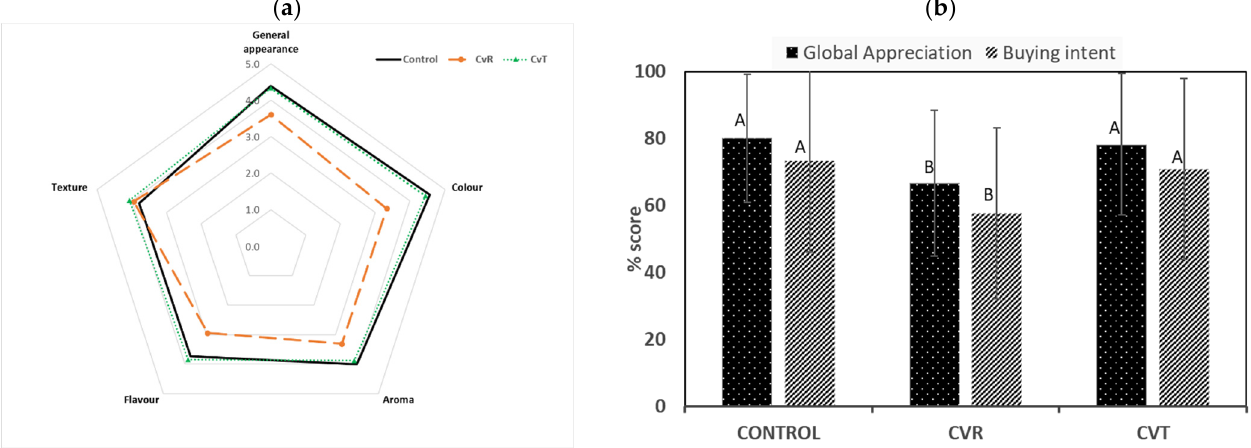
Figure 7. Average responses from the panelists (n = 33) for the control and the Chlorella vulgaris raw (CvR) and Chlorella vulgaris ethanol-treated (CvT) biomass-replaced (4%) breads for different sensorial attributes ( a ) and for global appreciation and buying intent ( b ). Different letters (where mentioned) indicate a significant difference ( p > 0.05) using the Fisher LSD test.